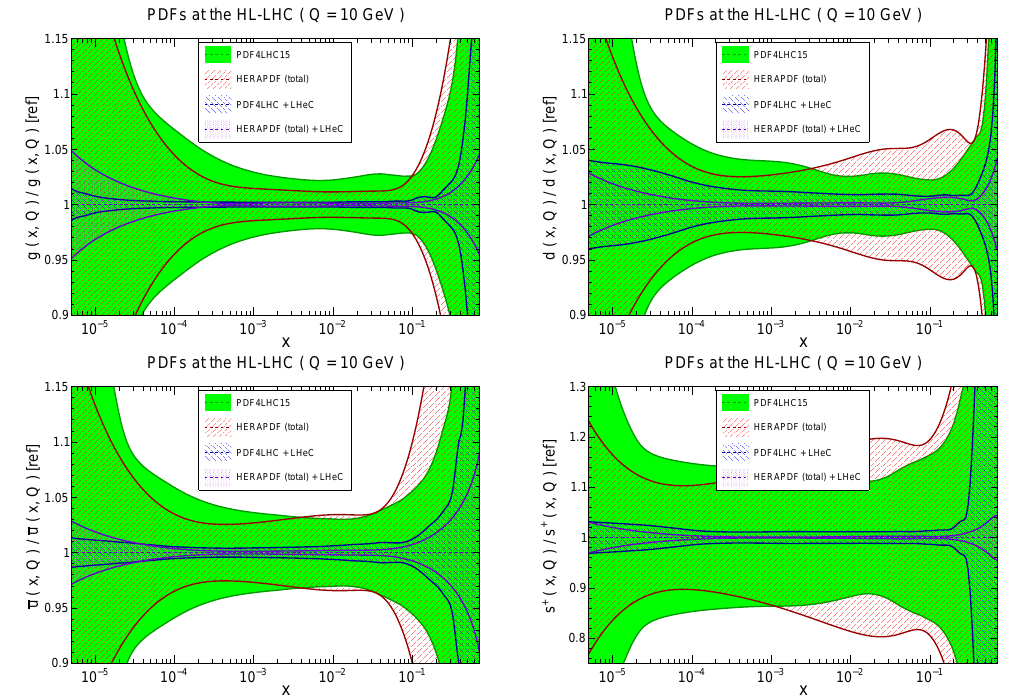
Figure 5.4: Same as Fig. 5.3, but with the error relative to each set